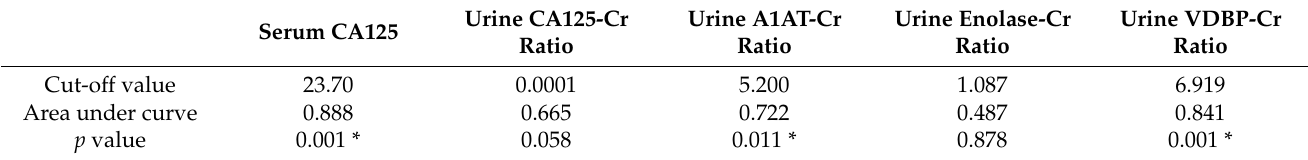
Table A5. The receiver operating characteristic (ROC) curve analysis of different single exam- ined biomarker.